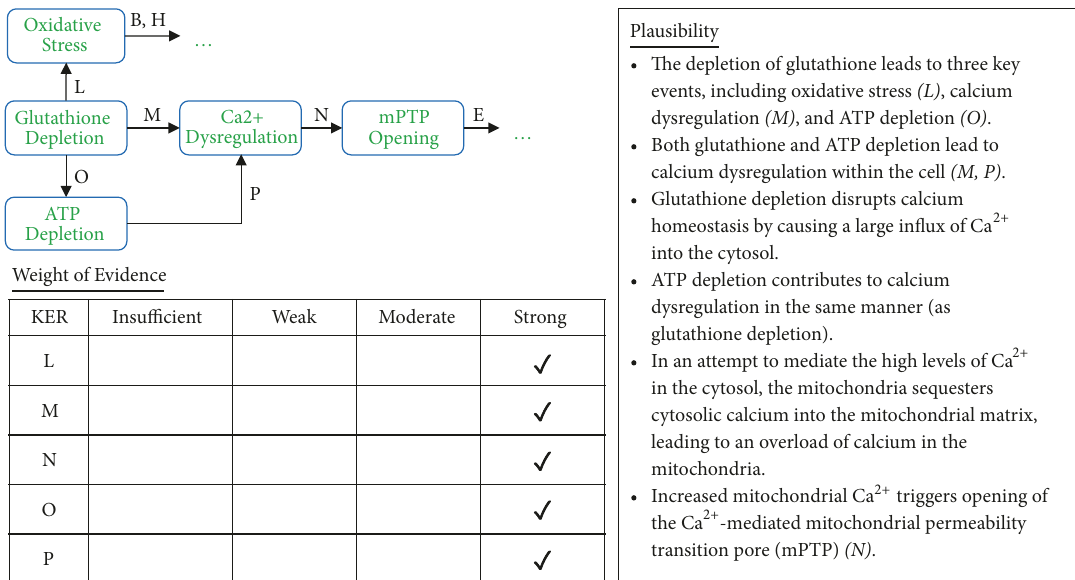
Figure 7: Analyses of Pathway II. A qualitative assessments of Key Event Relationships (KERs) in the AOP triggered by the generation of reactive oxygen species (MIE) and resulting in mitochondrial disease (AO) via KERs L, M, N, O, and P.